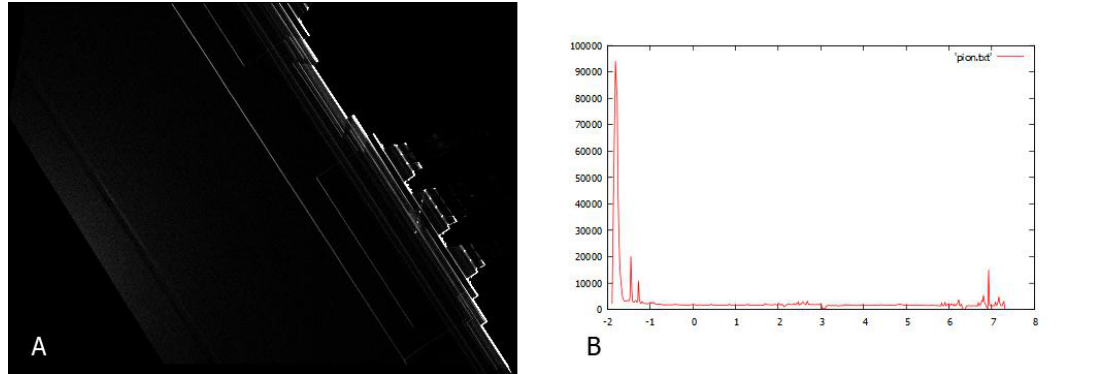
Fig. 2. Interim stages of determination of planes for the second object: (a) – the 2D histogram, (b) the 1D histogram – visible peaks correspond to the road and pavement surfaces